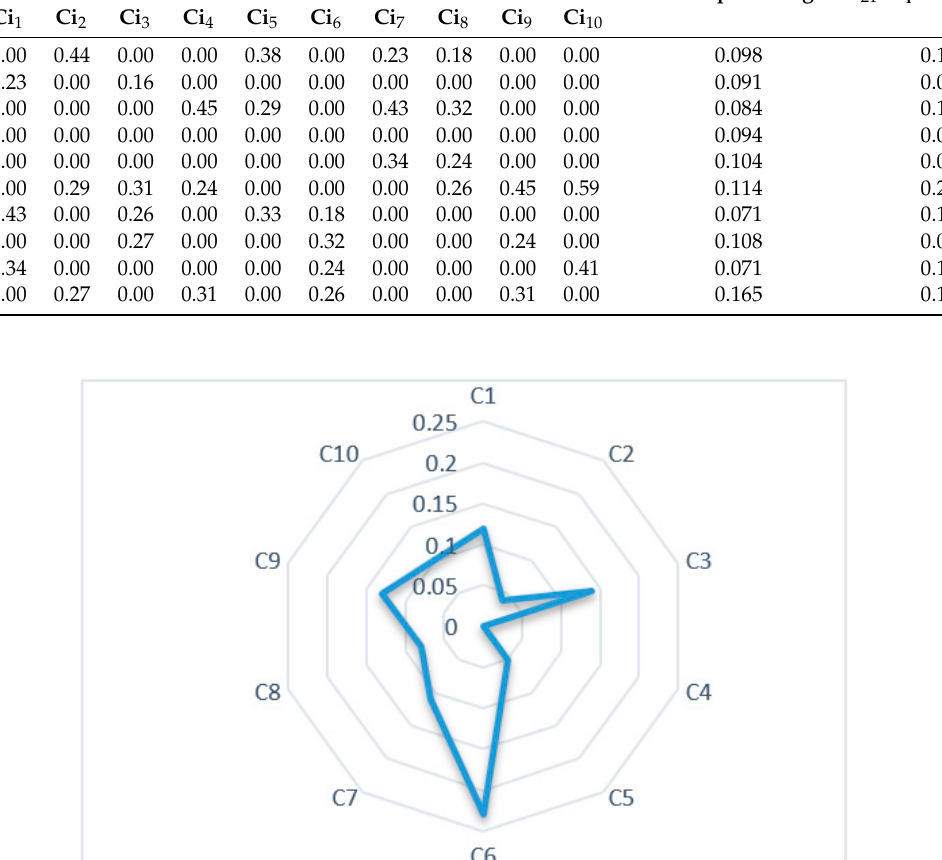
Table 16. Final weight for criteria using the ANP method.